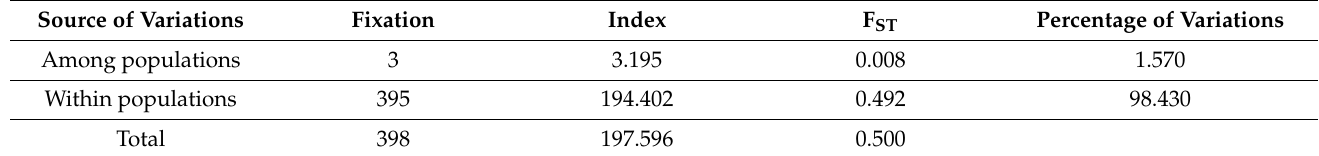
Table 4. Fixation index from haplotype